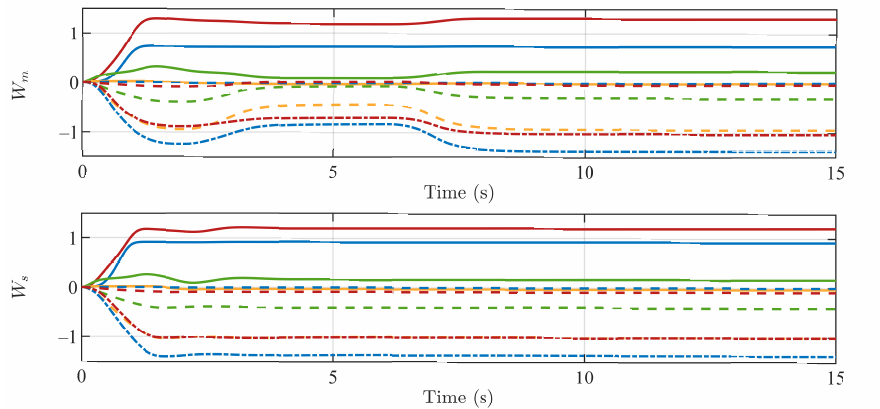
Figure 8. The adaptive parameters of ˆ W m and ˆ W s